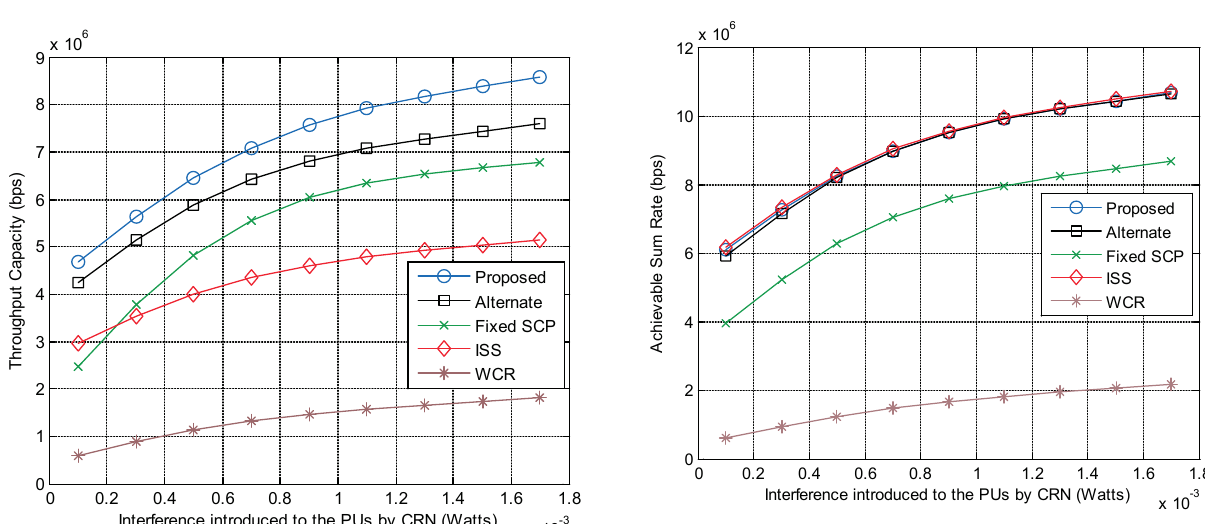
Figure 3. Throughput capacity of the CRN versus interference introduced to the PUs by several schemes with E [ | γ ( sr ) | 2 ] = 8 , E [ | γ ( ss ) | 2 ] = 3 and E [ | γ ( rs ) | 2 ] = 8 . MHz and 7 μ S, respectively. AWGN variance in all the channels is assumed to be 10 − 5 Watts. The PU’s transmit power ( P ) is considered to be 5 × 10 − 3 Watts. In the PU proposed algorithm, initial values of δ and τ for each CR subcarrier are randomly distributed between 0.01